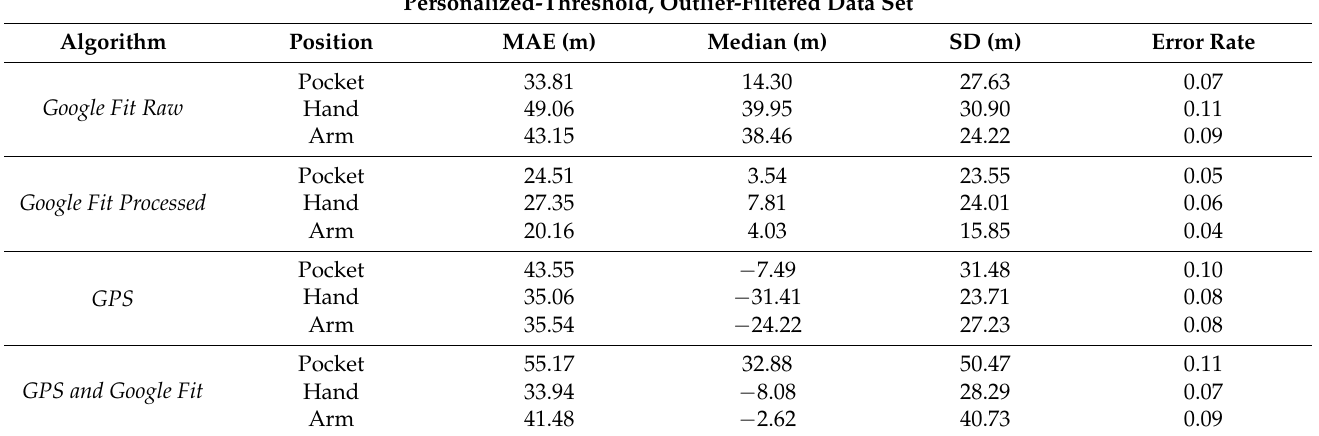
Table 1. Results of the smartphone-measured 6MWDs of a standardized 6MWT using different algorithms and different smartphone positions. MAE: mean absolute error, SD: standard deviation.